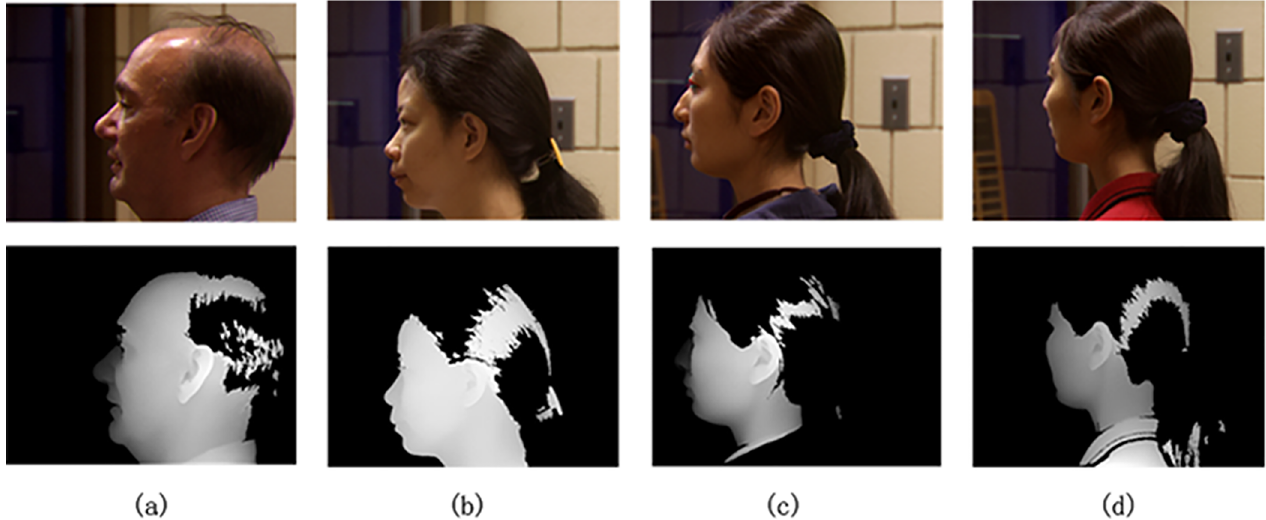
Fig 2. Examples of samples in UND collection J2. (a) A normal sample. (b) A sample with earrings. (c) & (d) Two samples of one person with a pose change.